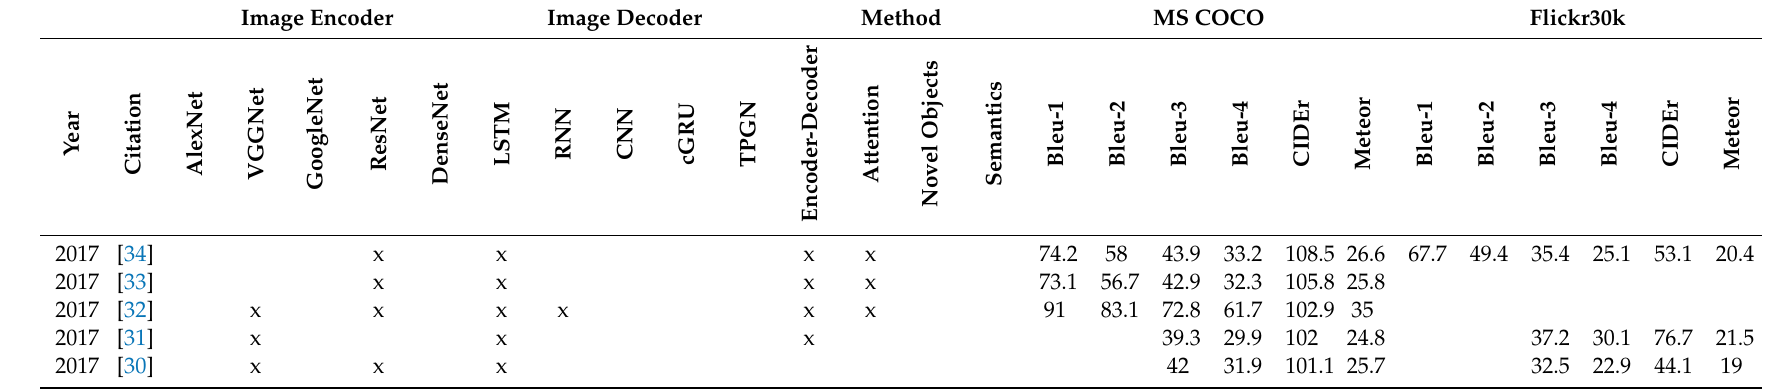
Table 6. Top 5 results in 2017 (sorted by CIDEr result on